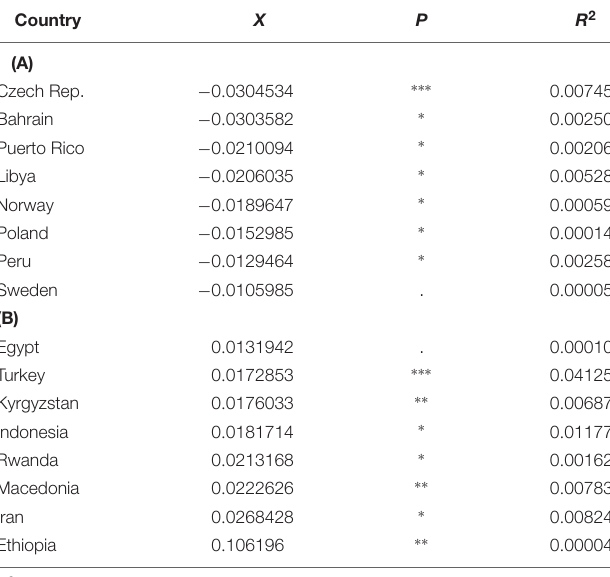
TABLE 2 | Estimates and significances of the linear mixed model of number of children on basis a Poisson error structure regressing on political orientation included as quadratic regression term, age, sex, education (lowest education level 1 as reference), scales of income, and frequency of attendance of religious services, with wave as random factor, separately for single countries of the WVS: (A) extreme political attitude is associated with reproductive advantages and (B) political moderate attitude is associated with reproductive advantages.